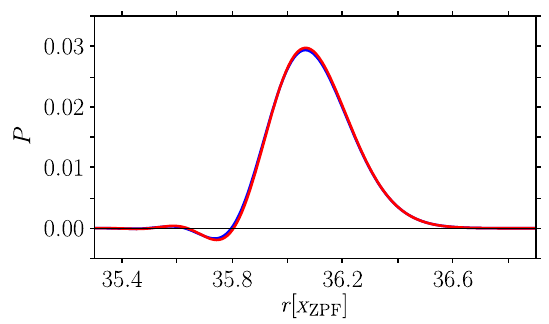
FIG. 7 (color online). Radial part of a Wigner function for parameters with high amplitude and many photons ( h a † a i ≈ 8 ) in the cavity featuring a very small Fano factor ( F ¼ 0 . 07 ) and some negative density. The parameters are ð g 0 ; κ 2 κ ; γ ; E; Δ Þ ¼ ð 0 . 033 ; 0 . 1 ; 0 ; 3 . 5 ; 0 . 03 Þ × ω lines are the results of two independent runs (each averaging 5000 mechanical oscillations) of the Monte Carlo-based steady-state